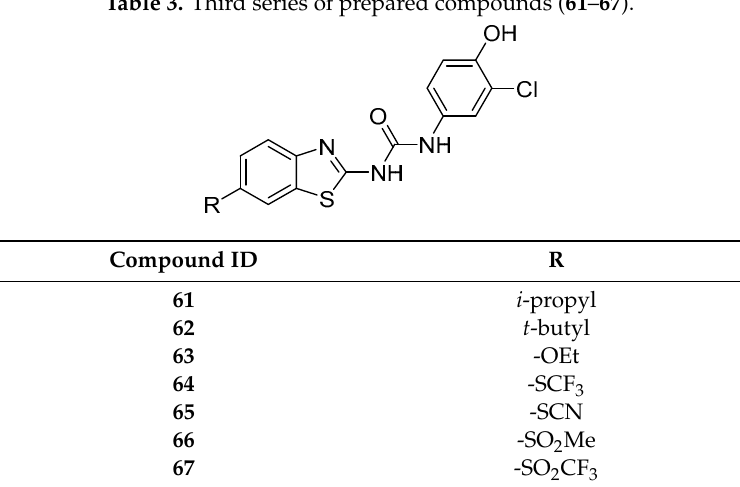
Table 3. Third series of prepared compounds ( 61 – 67 ).